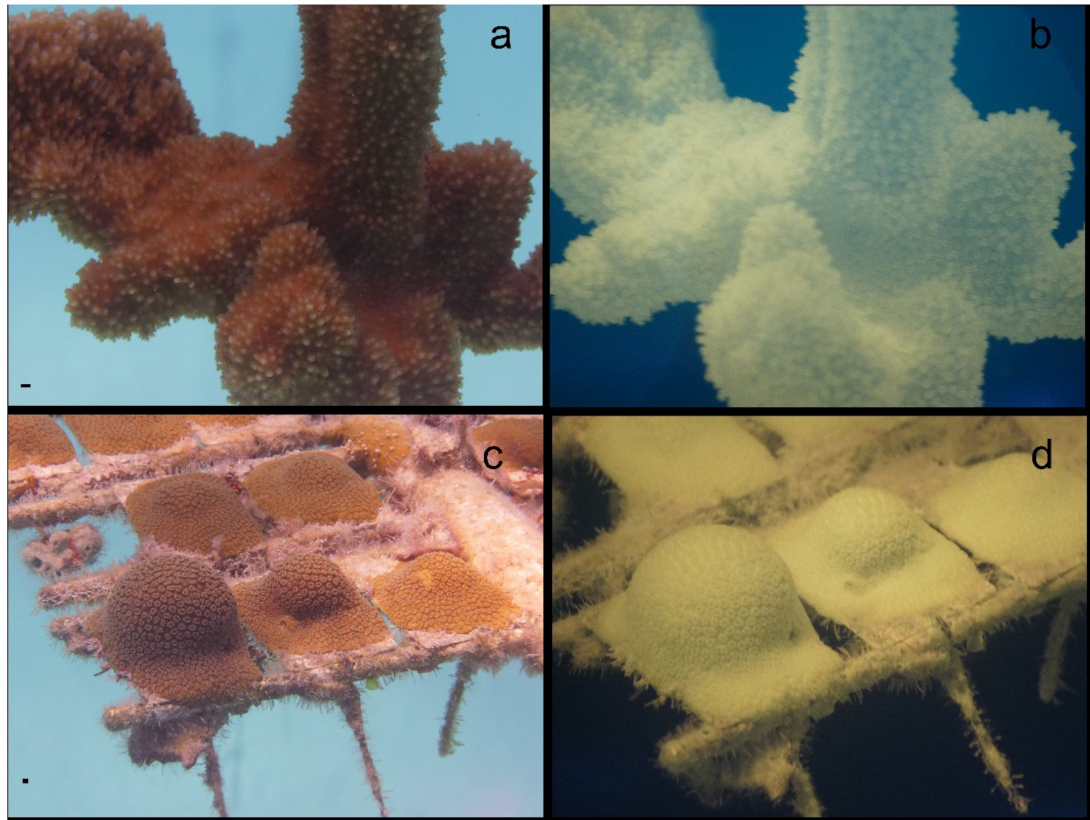
Figure 5. Visible and NIR Chl fluorescence images from two di ff erent Coral Restoration Foundation nursery coral species in ambient daylight. Images ( a , b ) are Acropora palmata suspended by a line on a “PVC nursery tree.” Images ( c , d ) are Montastraea cavernosa growing on plates attached to a PVC tree.